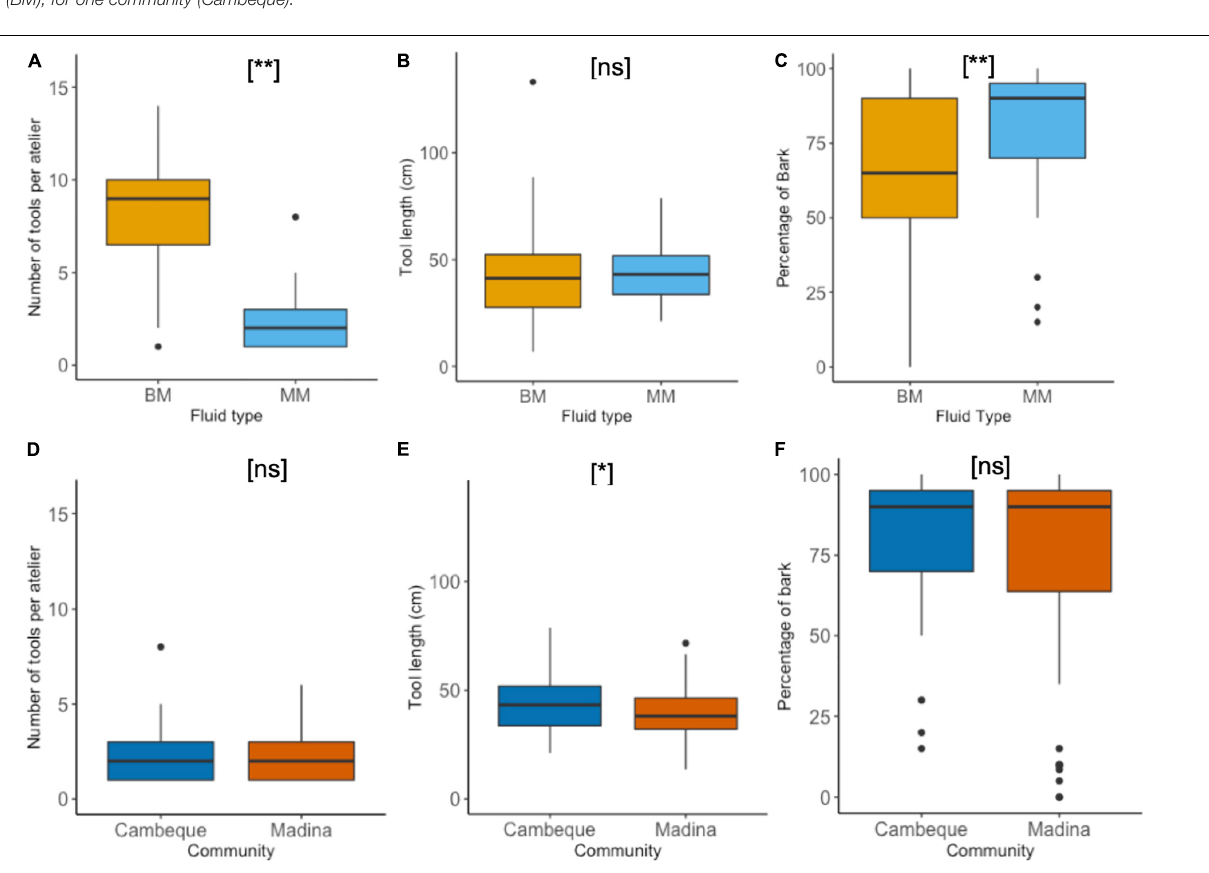
and Madina respectively. 5.4% of tools in Cambeque and 4.0% Madina had no signs of wear at either extremity. Tools with signs of wear at both ends were significantly more frequent in Madina ( n = 32, 32%) compared to Cambeque ( n = 5, 15.8%) (Chi-square test: X 2 2 = 4.495, p = 0.034); of these 56% and 40% tools had different wear patterns at the two ends for Madina and Cambeque, respectively. The average length of fray on frayed ends was longer in Cambeque (25.16 ± 11.91mm) than Madina